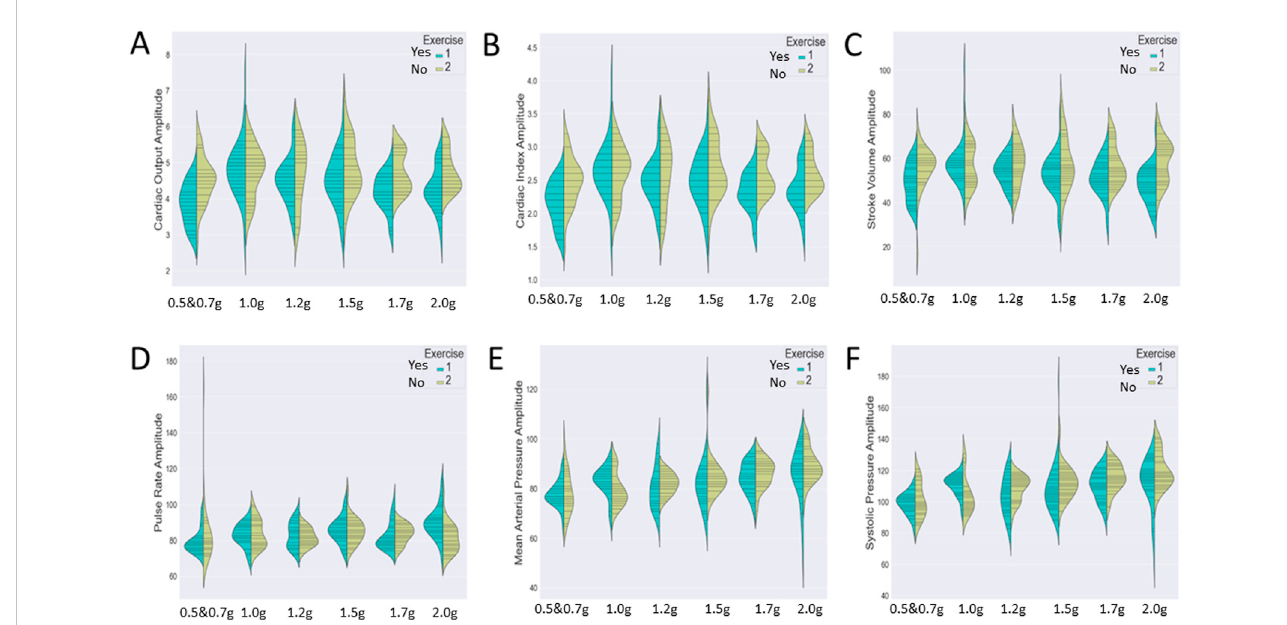
FIGURE 8 Visualization of six cardiac markers [ (A) cardiac output, (B) cardiac index, (C) stroke volume, (D) pulse rate, (E) mean arterial pressure, and (F) systolic pressure] comparing the effect of exercise, independently of the protocol. The number of measurements for SAHC alone (both protocols) was 30measurements(threemeasurementsperweek),andthatforcombinedwithexercise(bothprotocols)wasalso30measurements.Forthegripstrengthand balance, the measurements were taken upon arrival after 5 min standing for the “ pre ” values and 5 min after the end of centrifugation for the “ post ” values. The fi gure visualizes the distribution of each marker ’ s instance for AG training protocols A and B together with no exercise (1) (green color) and protocols A and B together with exercise (2) (yellow color)through ergometer and resistive exercise of arm/upper limb. Elongated violin plot edges represent the existence of outliners, while their width is proportional to the existence of the